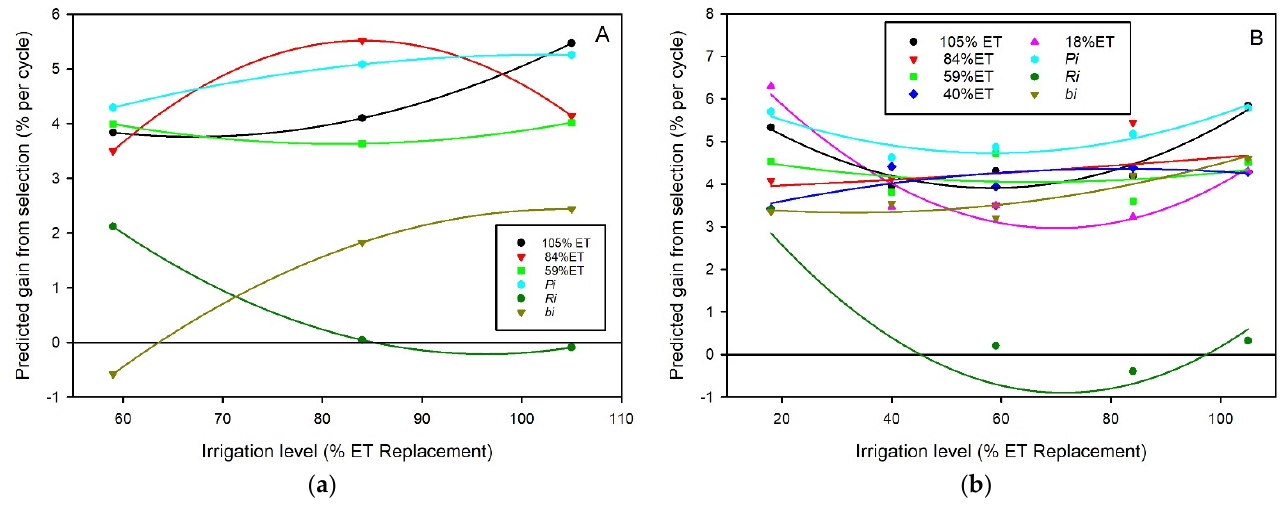
Figure 3. The predicted gain from selection and correlated response in forage mass across a range of deficit water levels (WL) when selection is based upon performance at WL, or average productivity ( P i ), resilience ( R i ), and stability ( b i ) across those WL: ( a ) model includes data from five harvests, or ( b ) seasonal total. A quadratic polynomial line is fit to the data. The genetic data is for 28 tall fescue half-sib families evaluated for forage mass in a line-source irrigation experiment with 5 water levels (%ET replacement) from 2001 to 2003 near Logan, UT, USA.